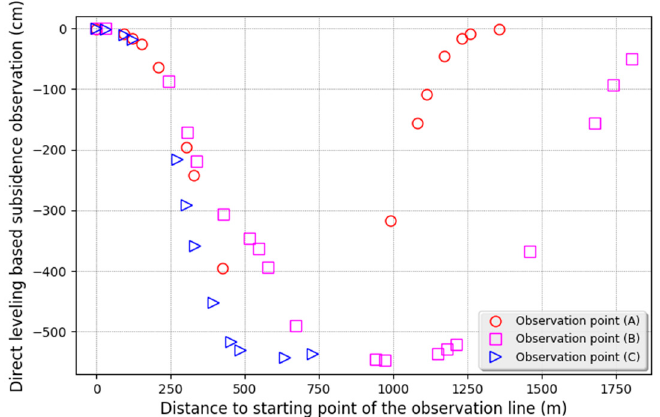
Figure 13. Fourth-order direct leveling-based subsidence observations for the observation line of A, B and C.